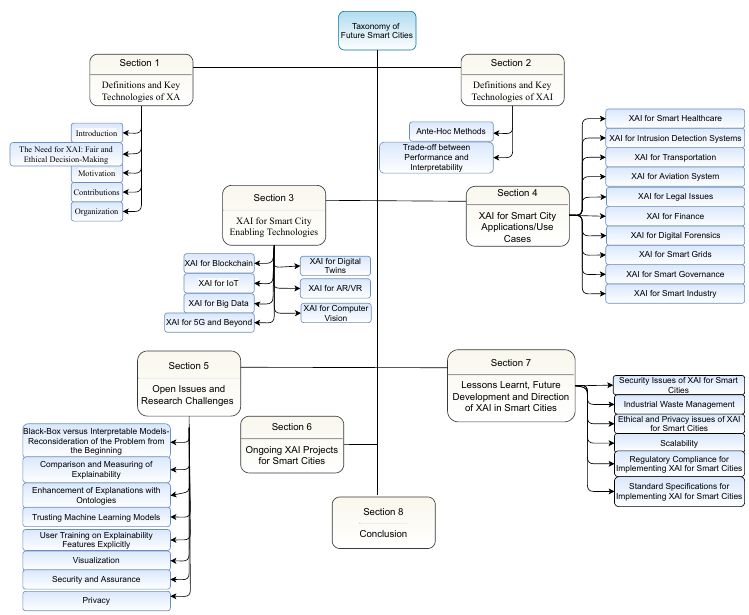
Figure 1. Taxonomy diagram of the explainable artificial intelligence for smart